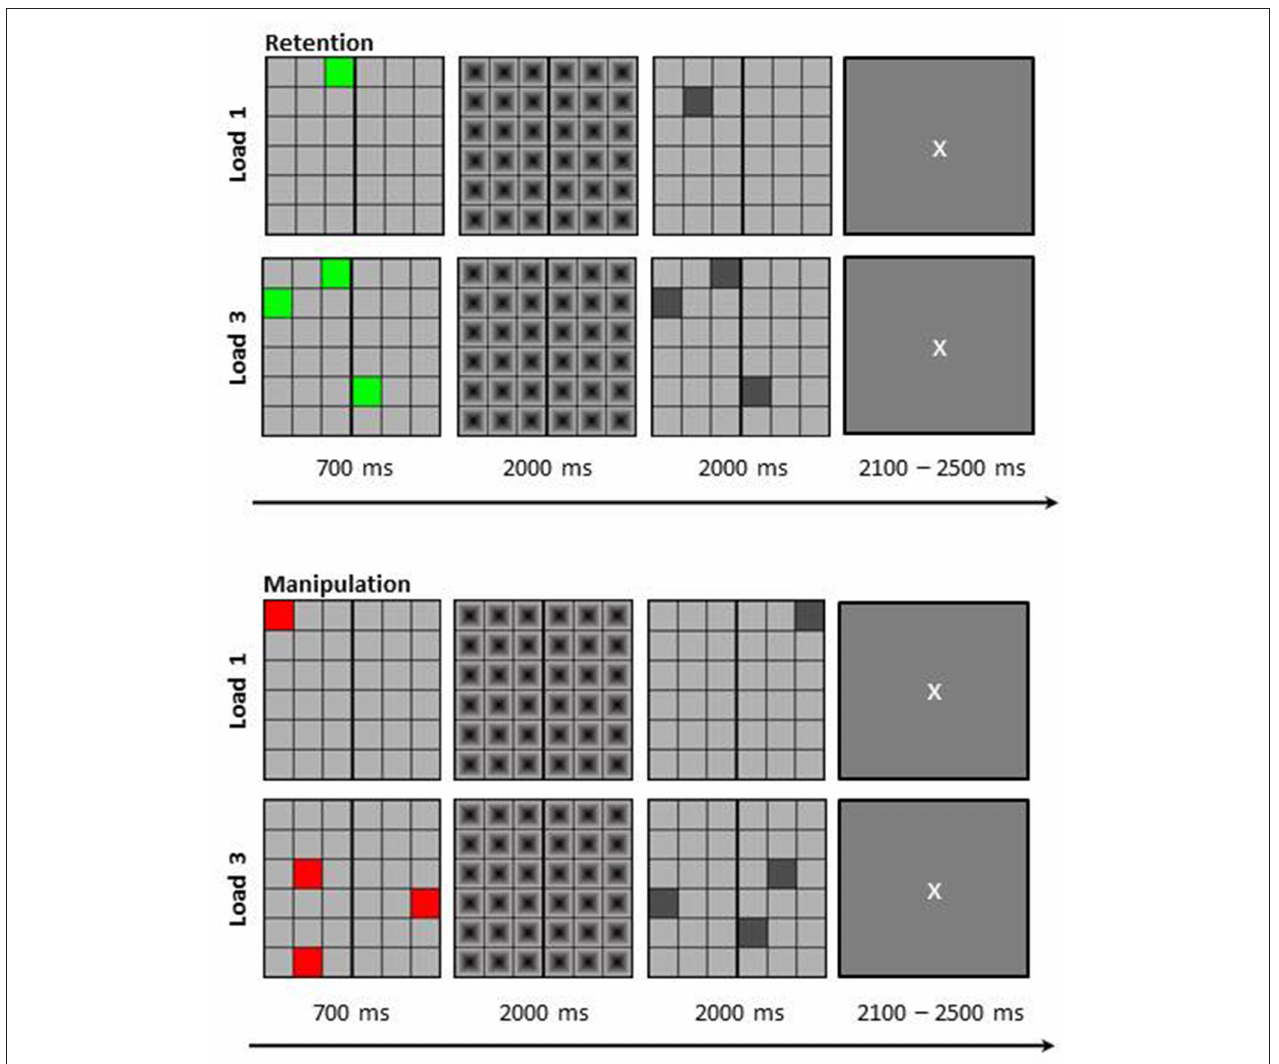
FIGURE 1 | Schematic depiction of the visuo-spatial delayed match to sample working memory task. Participants had to either retain the positions of the colored squares (Retention) or mirror their positions around the vertical line (Manipulation). The load was either one item (L1) or three items (L3). Figure taken with permission from Griesmayr et al.